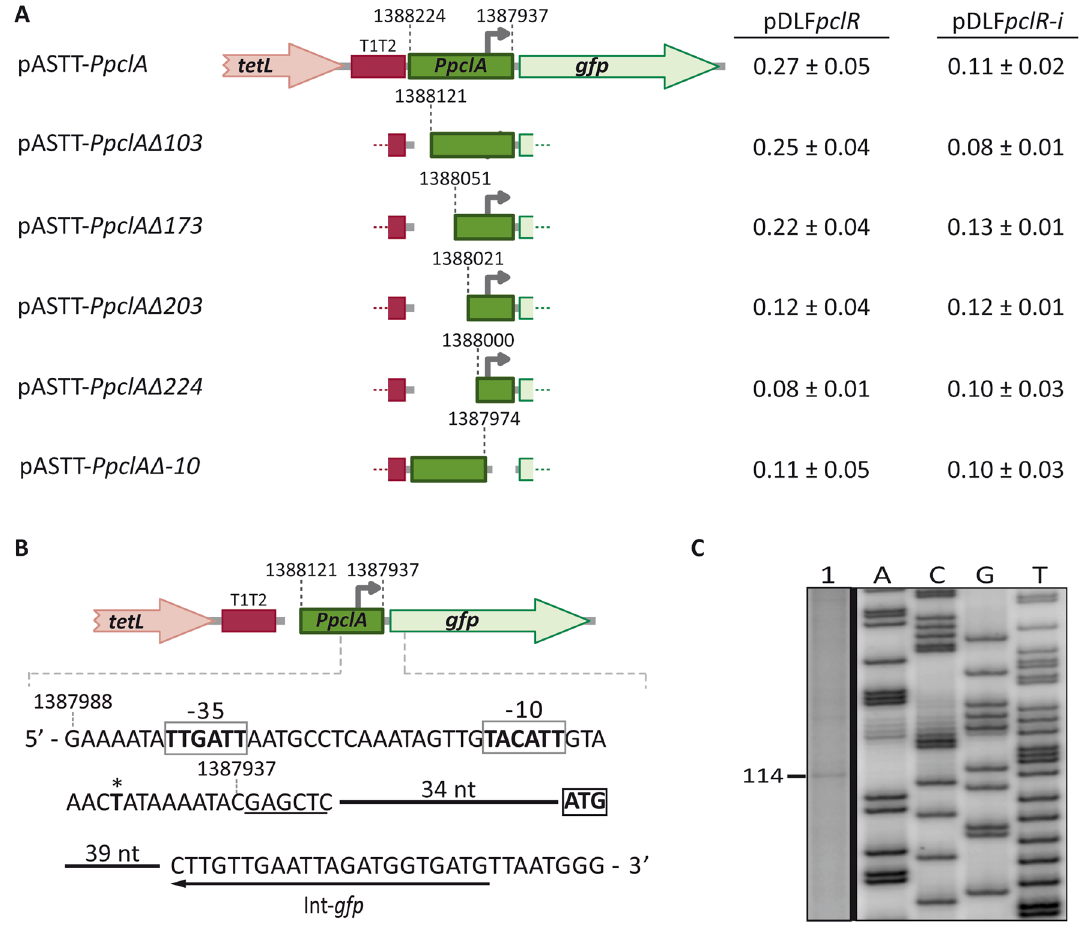
Figure 3. Identification of the PpclA promoter. (A) Fluorescence assays. Six regions of the R6 chromosome were amplified by PCR and inserted into the Sac I site of the promoter-probe vector pASTT. The coordinates of the inserted regions are indicated. The grey arrow represents the − 10 element of the PpclA promoter. See also legend to Fig. 2A. (B) Plasmid pASTT- PpclA∆103 . The main sequence elements (− 35 box and − 10 box) of the PpclA promoter and the ATG translation start codon of the gfp gene are indicated. The Sac I site is underlined. The position of the Int- gfp oligonucleotide used for primer extension is shown. The asterisk indicates the transcription start site identified in this work. (C) Primer extension reaction using total RNA from strain R6∆ mga /pDLF pclR /pASTT- PpclA ∆103. The Int- gfp oligonucleotide was used as a primer. Dideoxy-mediated chain termination sequencing reactions (M13mp18 DNA and primer − 40 M13 36 ) were run in the same gel as DNA size markers. The corresponding lanes (A, C, G, and T) came from the same gel but were taken at a lower exposure (delineation with dividing lines). See the full-length gel (high and low exposures) at the end of the Supplementary Information file. The size (in nucleotides) of the cDNA product is indicated on the left of the